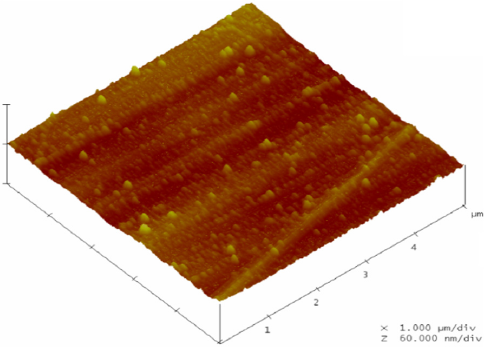
Figure 8. AFM image of an epoxy-zirconia-silica hybrid sol-gel coating surface topography with nanosized particles incorporated in the matrix [123].